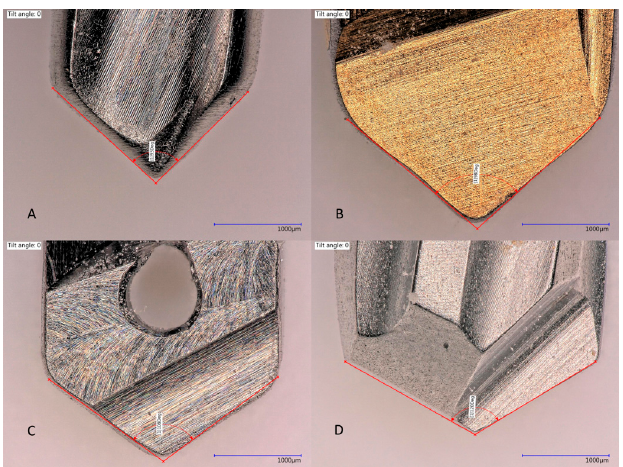
Figure 2. Drill tip angles. Composition image of the four drill tips used in this experiment. ( A ) Anker tapered drill tip, angle: 93 degrees; ( B ) Megagen tapered drill tip, angle: 98 degrees; ( C ) Nobel Biocare tapered drill tip, angle: 108 degrees; and ( D ) Densah tapered drill tip, angle: 120 degrees.